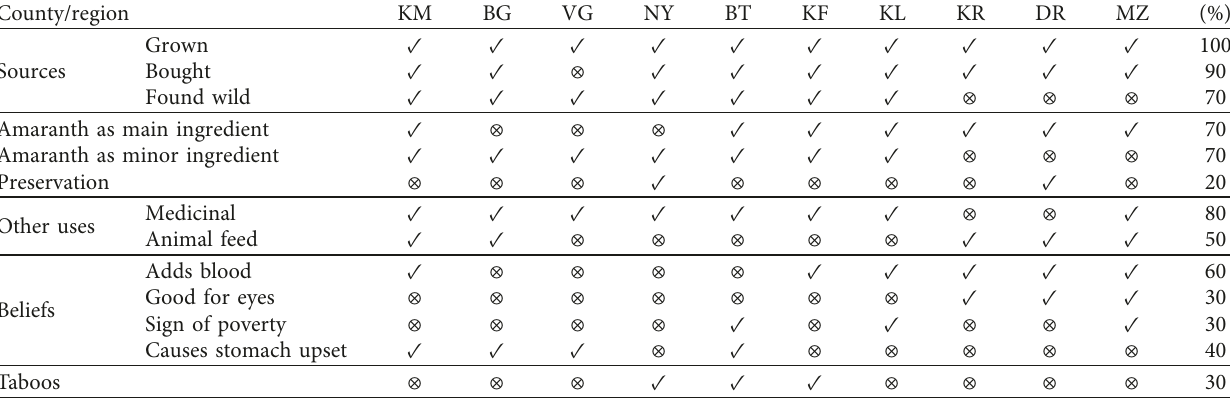
Table 1: Summary of responses from survey in Kenya and